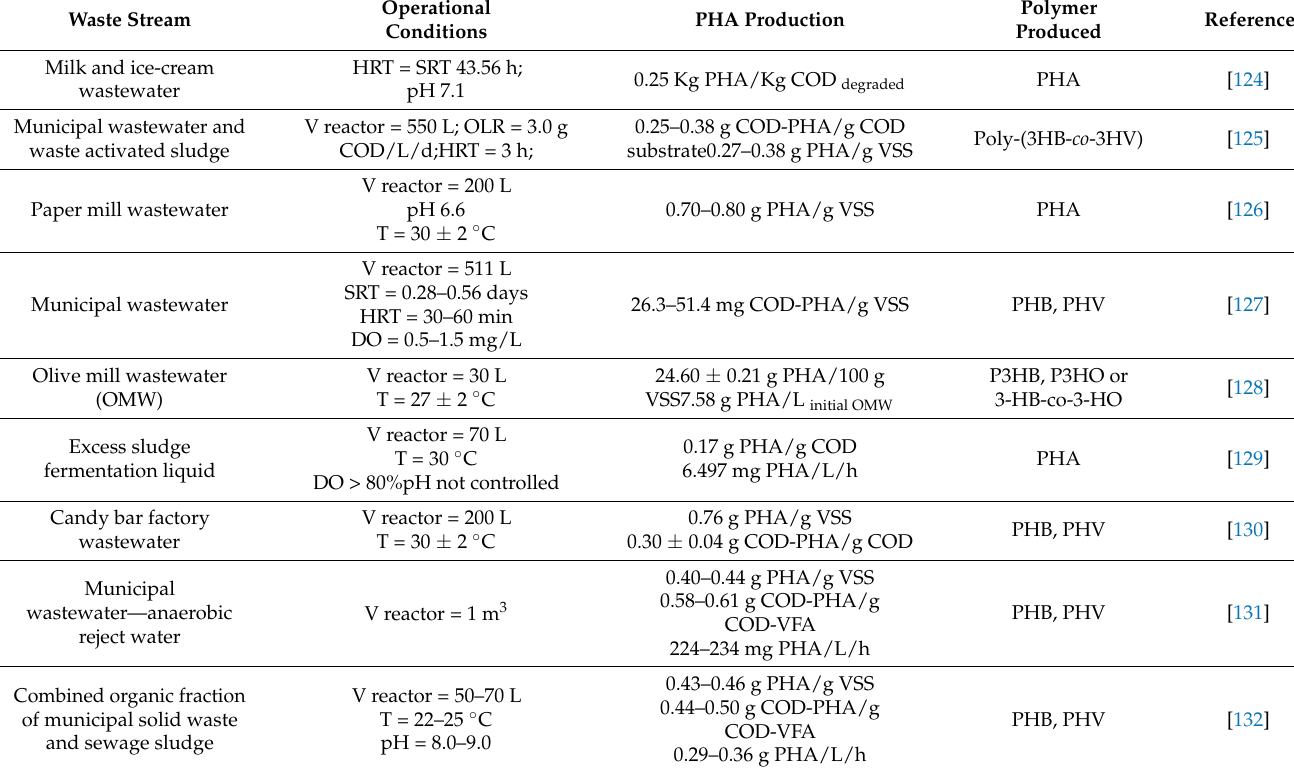
Table 10. PHA production using mixed microbial cultures at